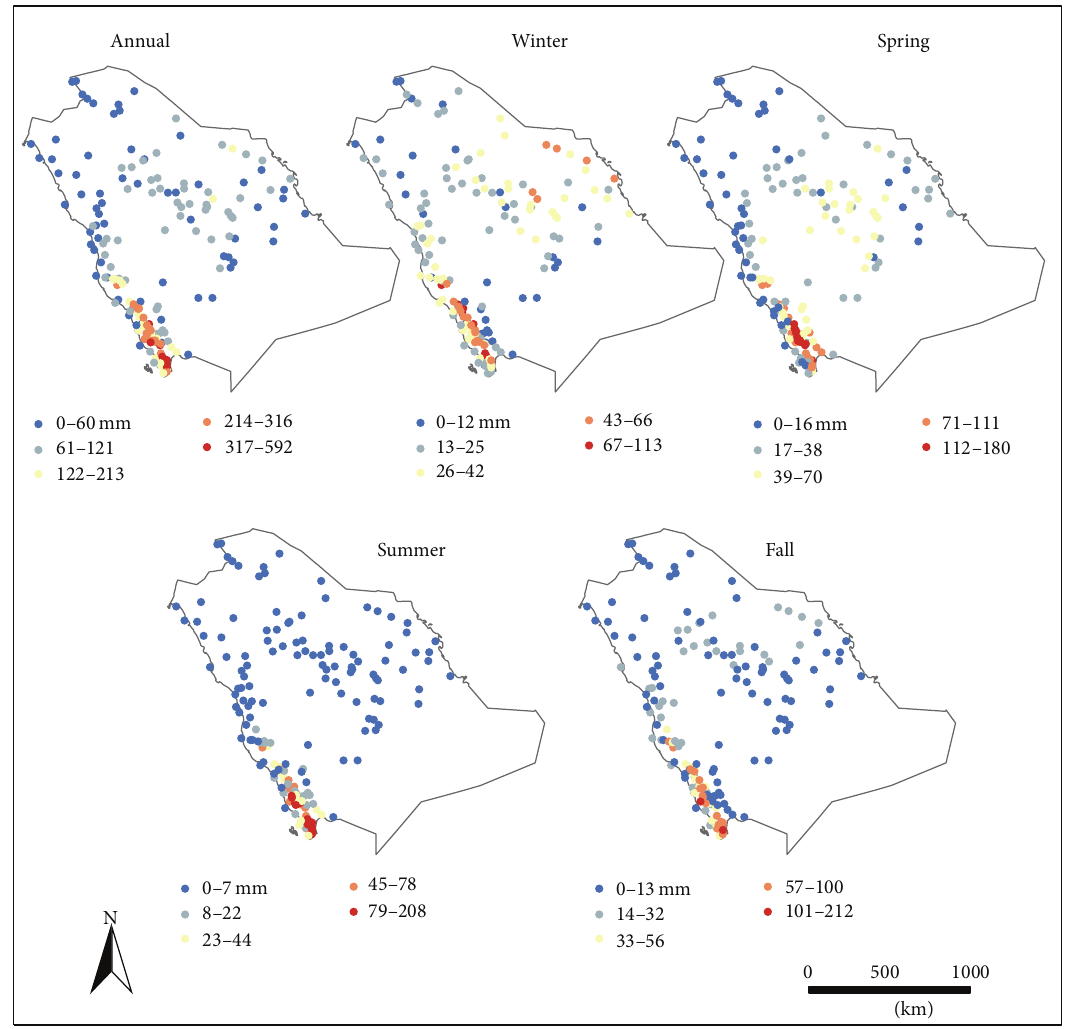
Figure 4: Mean annual and seasonal rainfall distribution in Saudi Arabia (1971–2005).